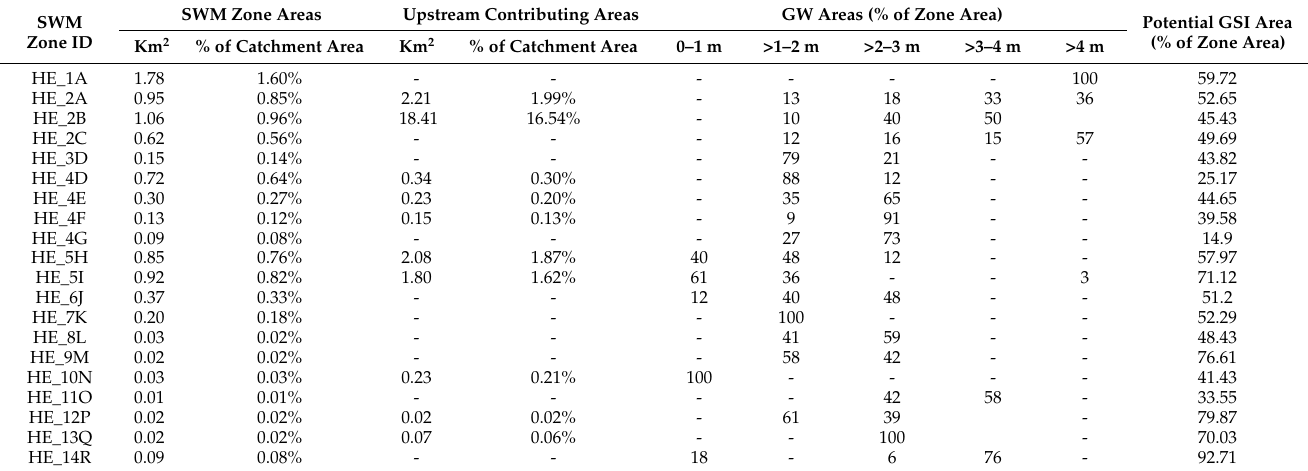
Table 1. Land characteristics of SWM zones in the Heathcote River